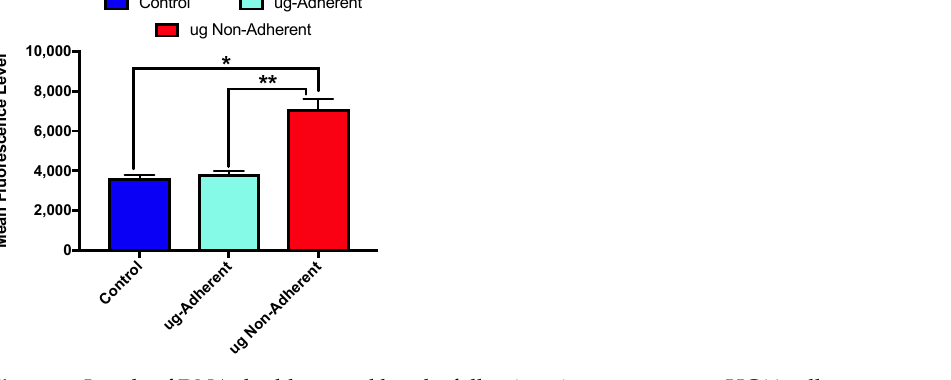
Figure 3. Levels of DNA double-strand breaks following sim µg exposure. HC11 cells were exposed to sim µg for 6 days and then assayed for levels of γ H2AX using a fl ow-cytometry-based assay that de fi nes average levels of fl uorescence per cell; * p = 0.0002, ** p = 0.0009. 2.4. Simulated Microgravity Causes an Increase in Apoptosis Speci fi cally in Non ‐ Adherent Cells Previous studies have also noted di ff erences in apoptosis following sim µg exposure.